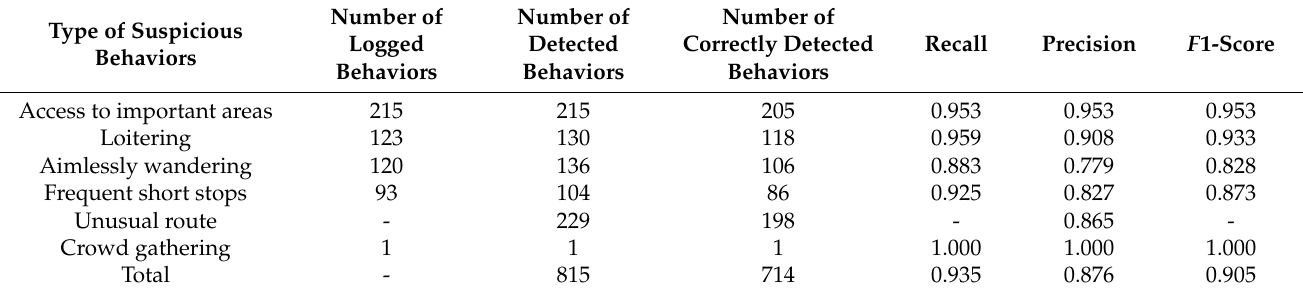
Table 1. Accuracies of the detection algorithms for the suspicious